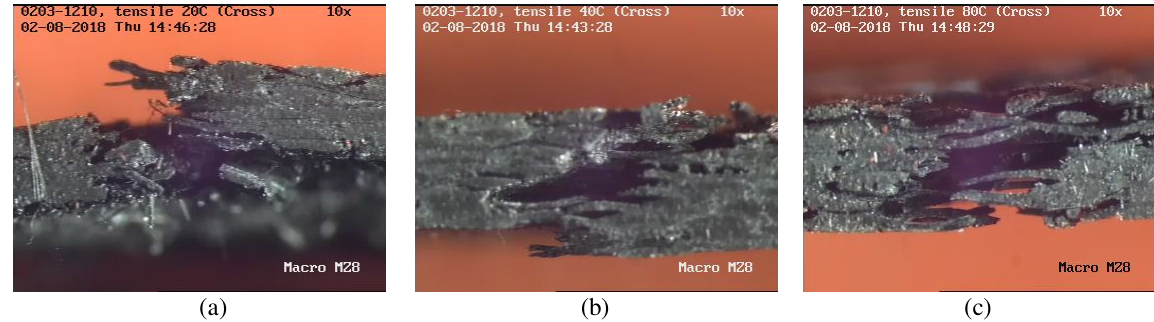
Fig 7: Enhanced images of failed sample in tensile test